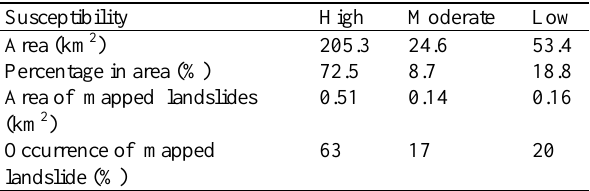
Table 3. Classification of landslide susceptibility, areas and numbers of landslides identified in each